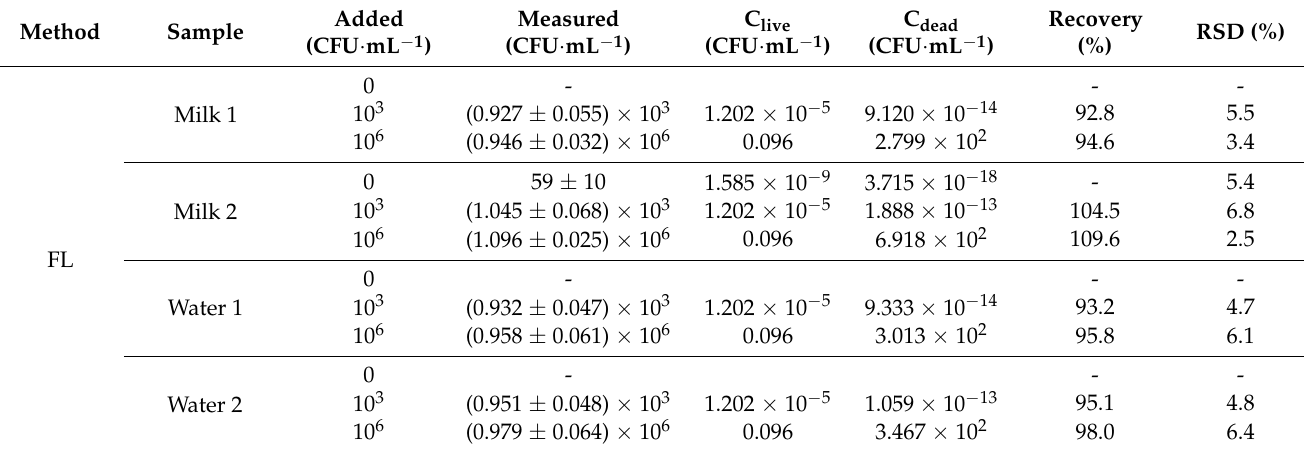
Table 2. Detection of total S.T in real samples by FL ( n =3).